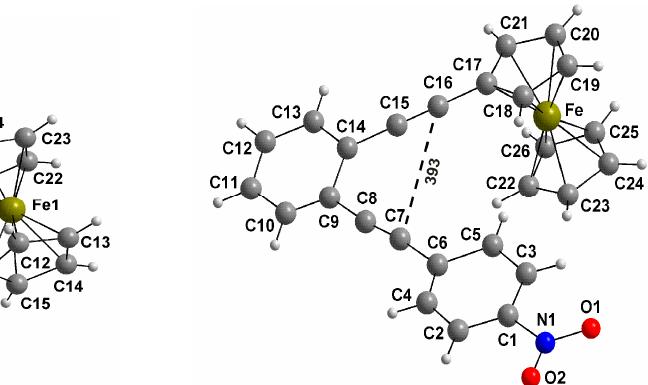
Figure 1. Crystal structures of 3 ( left ) and 8 ( right ). Critical distances are given in